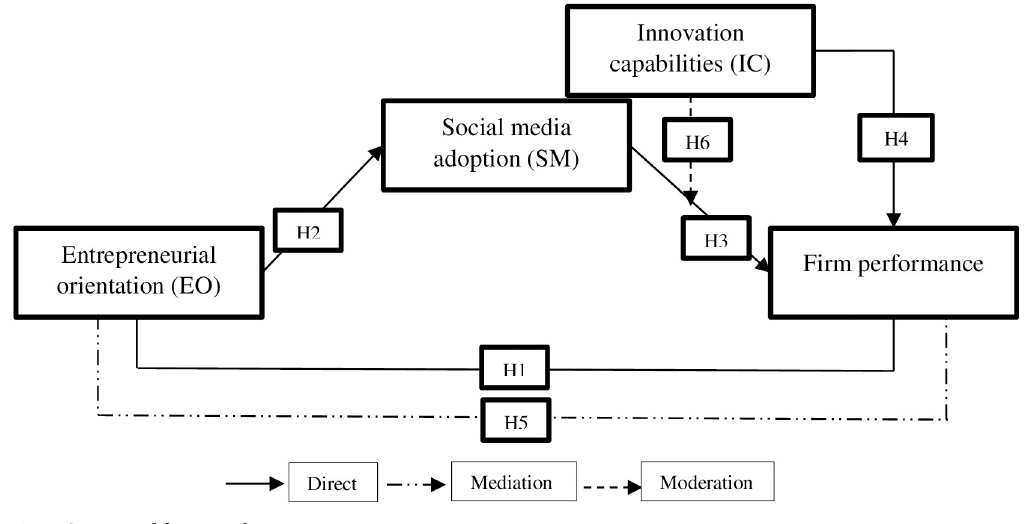
Fig 1. Conceptual